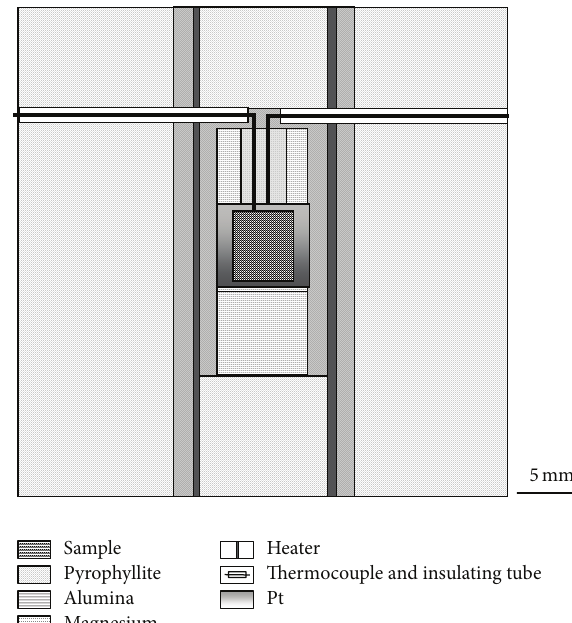
Figure 1: Experimental assembly used in the high pressure syn- thesizing experiments with a multianvil pressure apparatus (YJ- 3000T) installed at the Institute of Geochemistry, Chinese Academy of